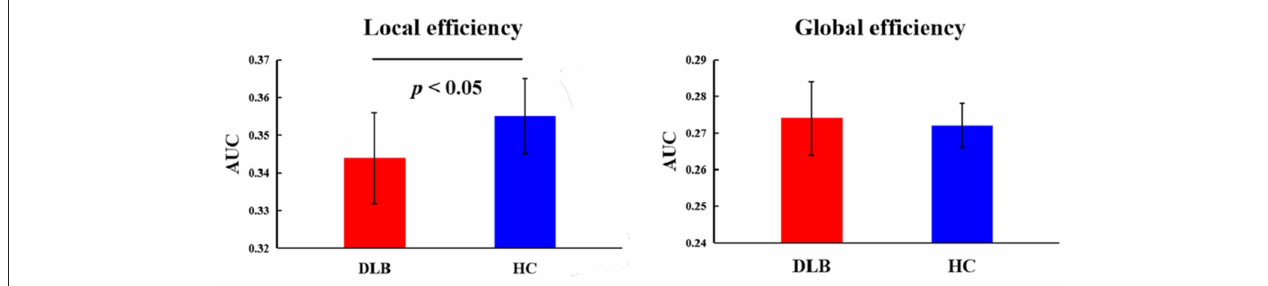
FIGURE 4 | Topological properties of static functional connectivity. The comparison between HC and the DLB group with respect to the local and global efficiency. p -value results from two-sample t -tests. See Table 3 for detailed